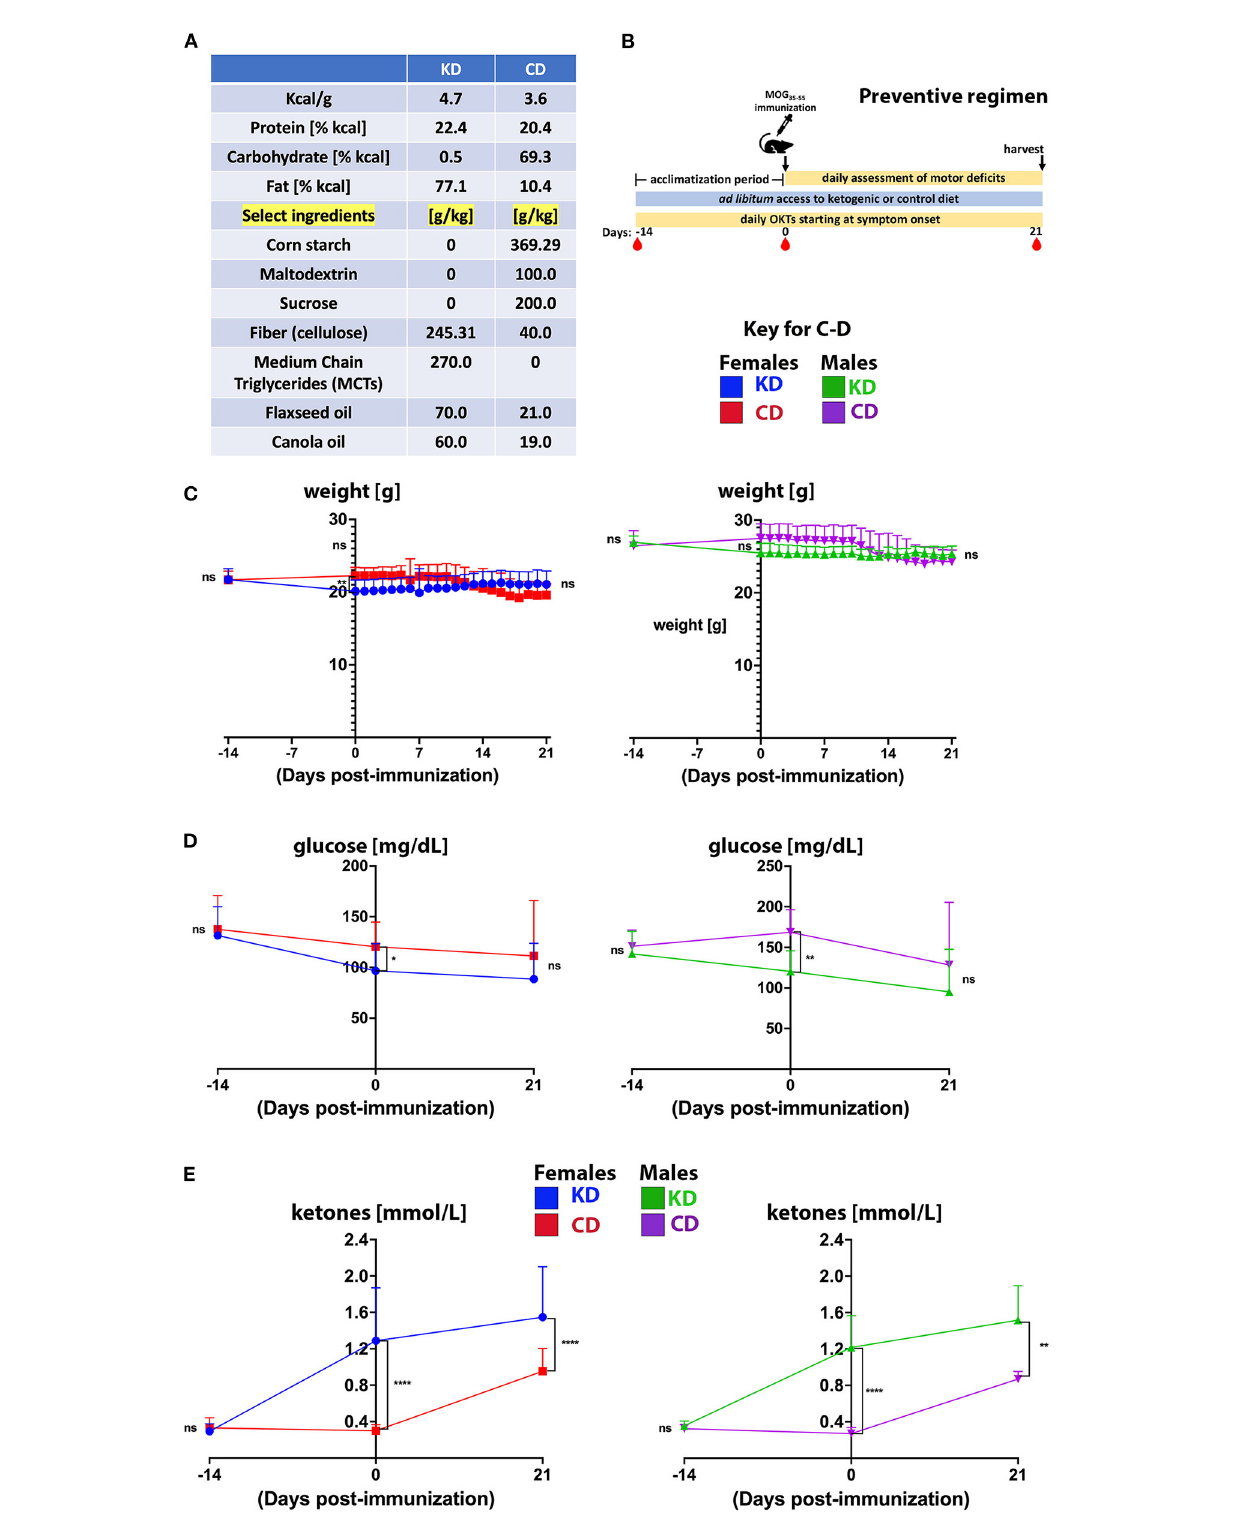
FIGURE1 The KD stabilizes body weight and blood glucose but increases circulating ketones. (A) Macromolecular compositions of diets. The sources of carbohydrate in the CD are corn starch, maltodextrin, sucrose, and fiber in the form of cellulose. The only carbohydrate in the KD is cellulose. The fat content of the KD is derived from MCTs (C8 and C10), flaxseed oil, and canola oil. (B) Outline of experimental approach for the preventive regimen. Mice were fed a KD or CD for 2 weeks prior to MOG 35 − 55 immunization to acclimate and were maintained on their respective diets for the duration of the experiment. Motor scores and visual acuity were tracked daily, and blood draws (red drop symbol) for glucose and ketone levels were taken at days − 14, 0, and 21 dpi. Tissues and plasma were harvested 3 weeks post immunization at study termination. (C–E) Graphs of body weights (C)